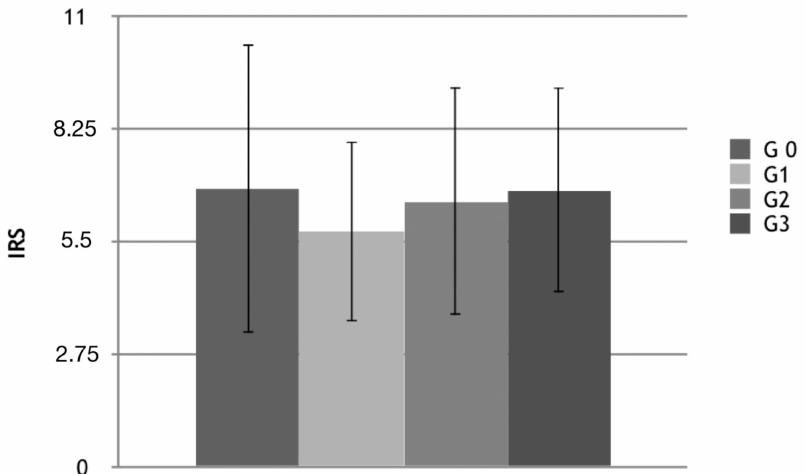
Figure 4. Evaluation by IRS scale of tissue vaspin expression in the study and control groups: IRS, Immunoreactive scale; G0–3, grading